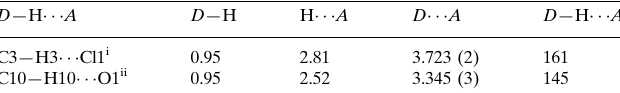
Hydrogen-bond geometry (A˚ , (cid:1)